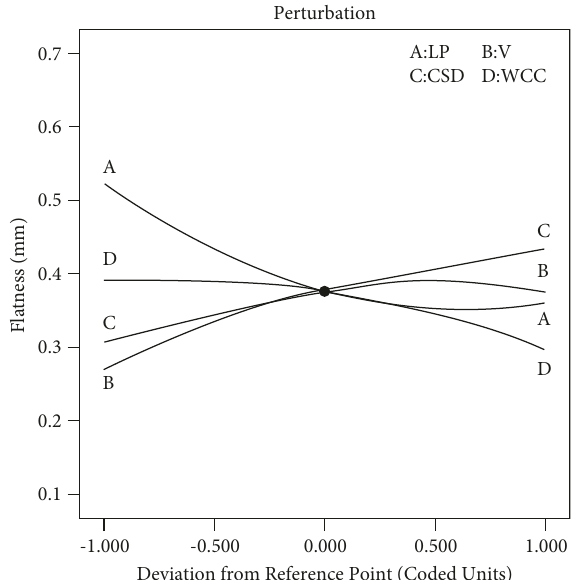
Figure 9: Perturbation diagram of the process parameters on the surface flatness.